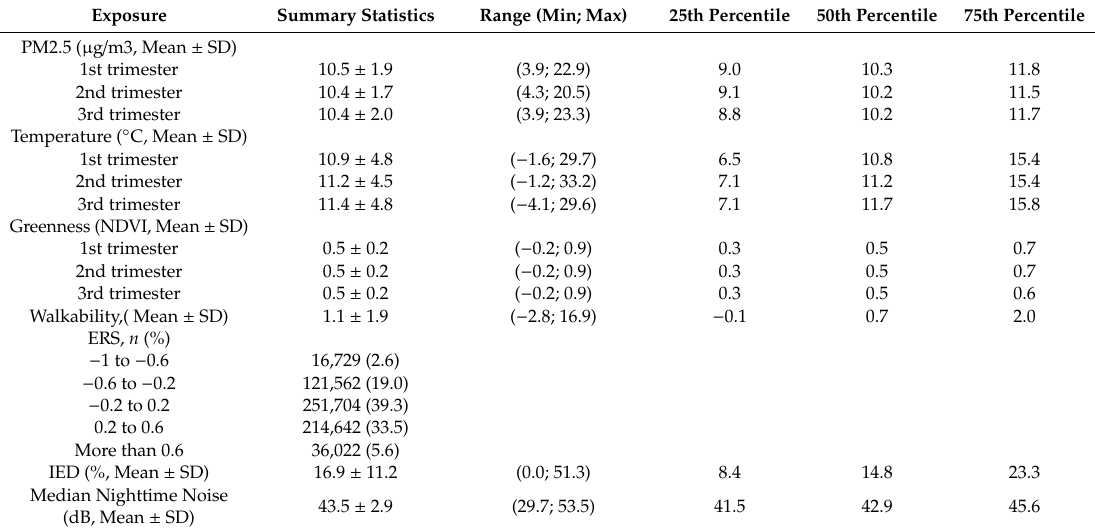
Table 2. Summary statistics of the environmental exposures, built environment characteristics, and economic indices during pregnancy of women who gave birth in Massachusetts between 2001 and 2011 ( n = 640,695). Exposure Summary Statistics Range (Min;